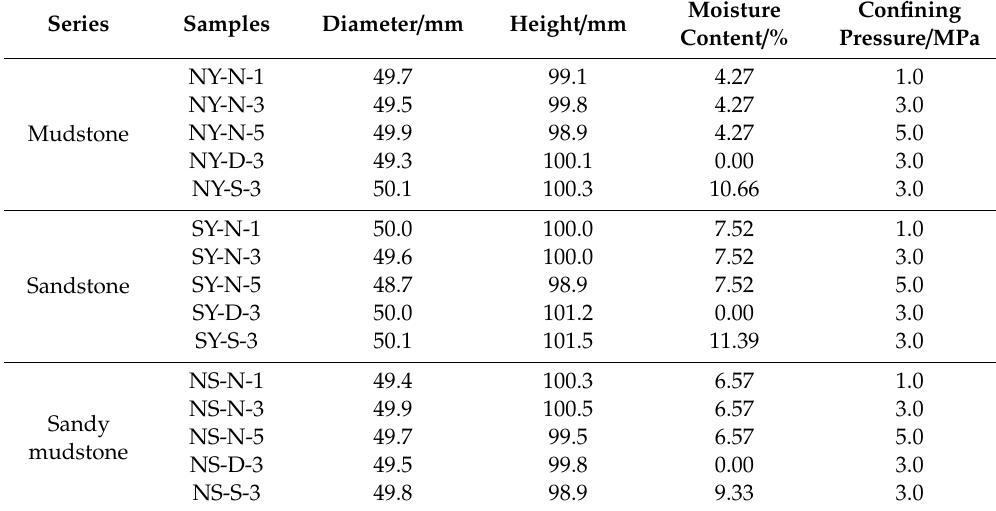
Table 1. Details of rock